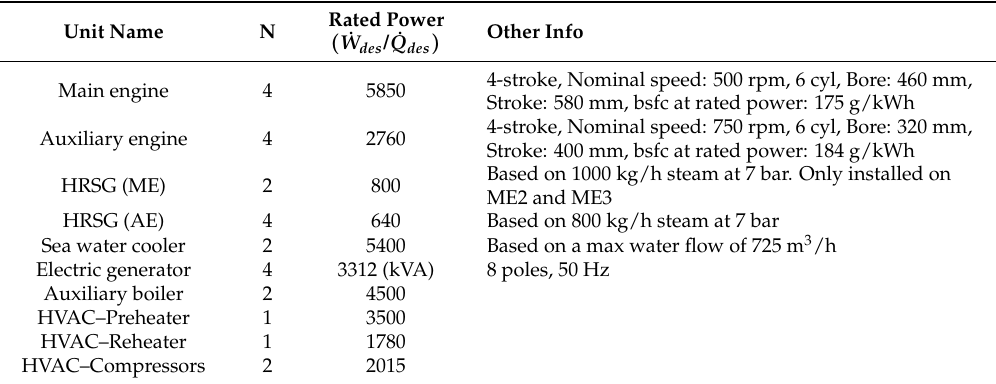
Table 1. List of the main components of the ship energy